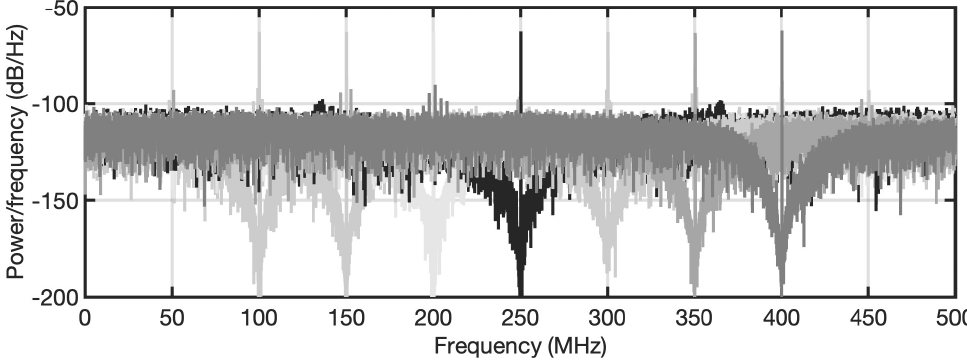
f s to f n = 0.4 f s ( f s = 1 · ·